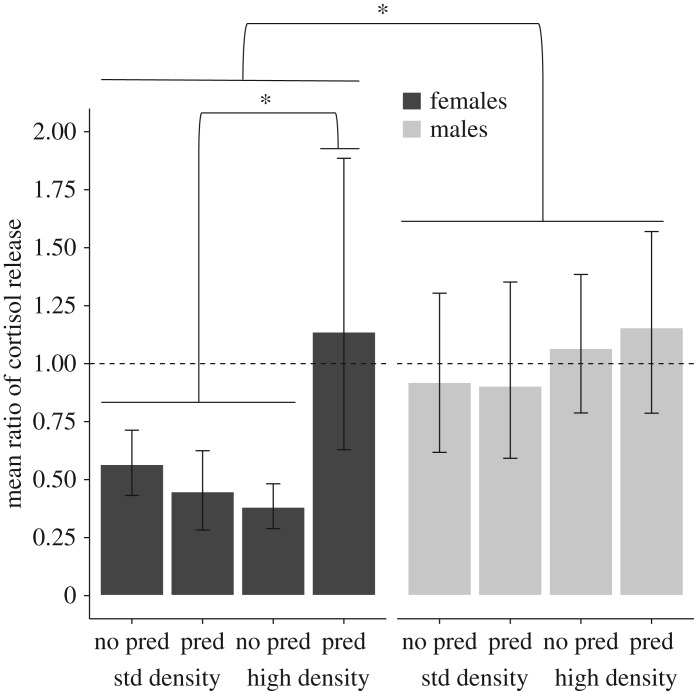
Ratio of cortisol between the 2 h long collection periods (cortisol in collection 2 divided by cortisol in collection 1). Values less than 1 (dotted line) indicate a decrease in cortisol release, values around 1 indicate no change and above 1 indicate an increase in cortisol release in the second collection period. The x-axis shows the developmental manipulation of predation cues (predation versus no-predation) and housing density (high versus standard), and bar shading sex (black: females; grey: males). Means ± 95% CI. The asterisks indicate significant differences of p < 0.05.